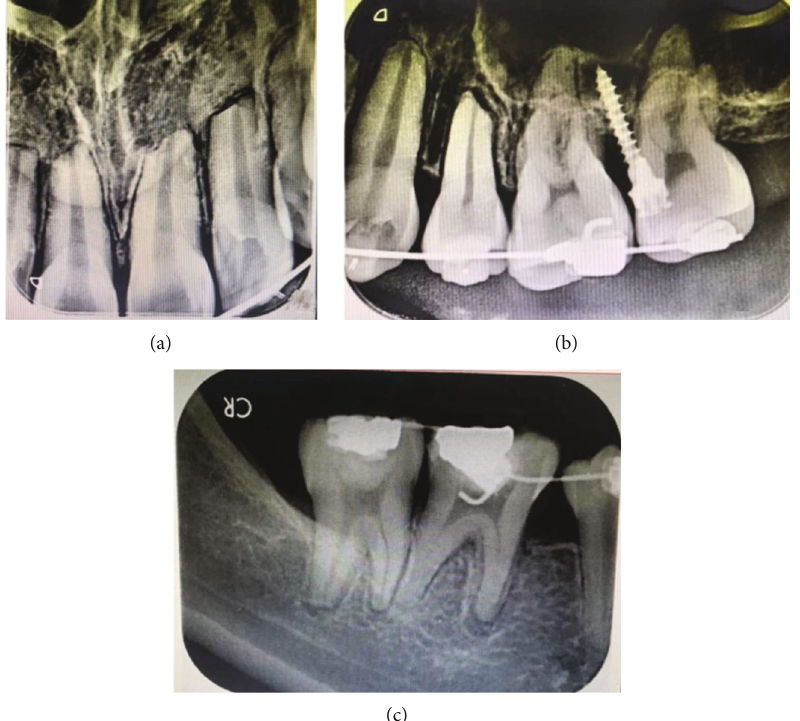
Figure 4: Intraoral periapical radiographs of (a) maxillary incisors, (b) maxillary left posterior teeth, and (c) mandibular right posterior teeth showing severe